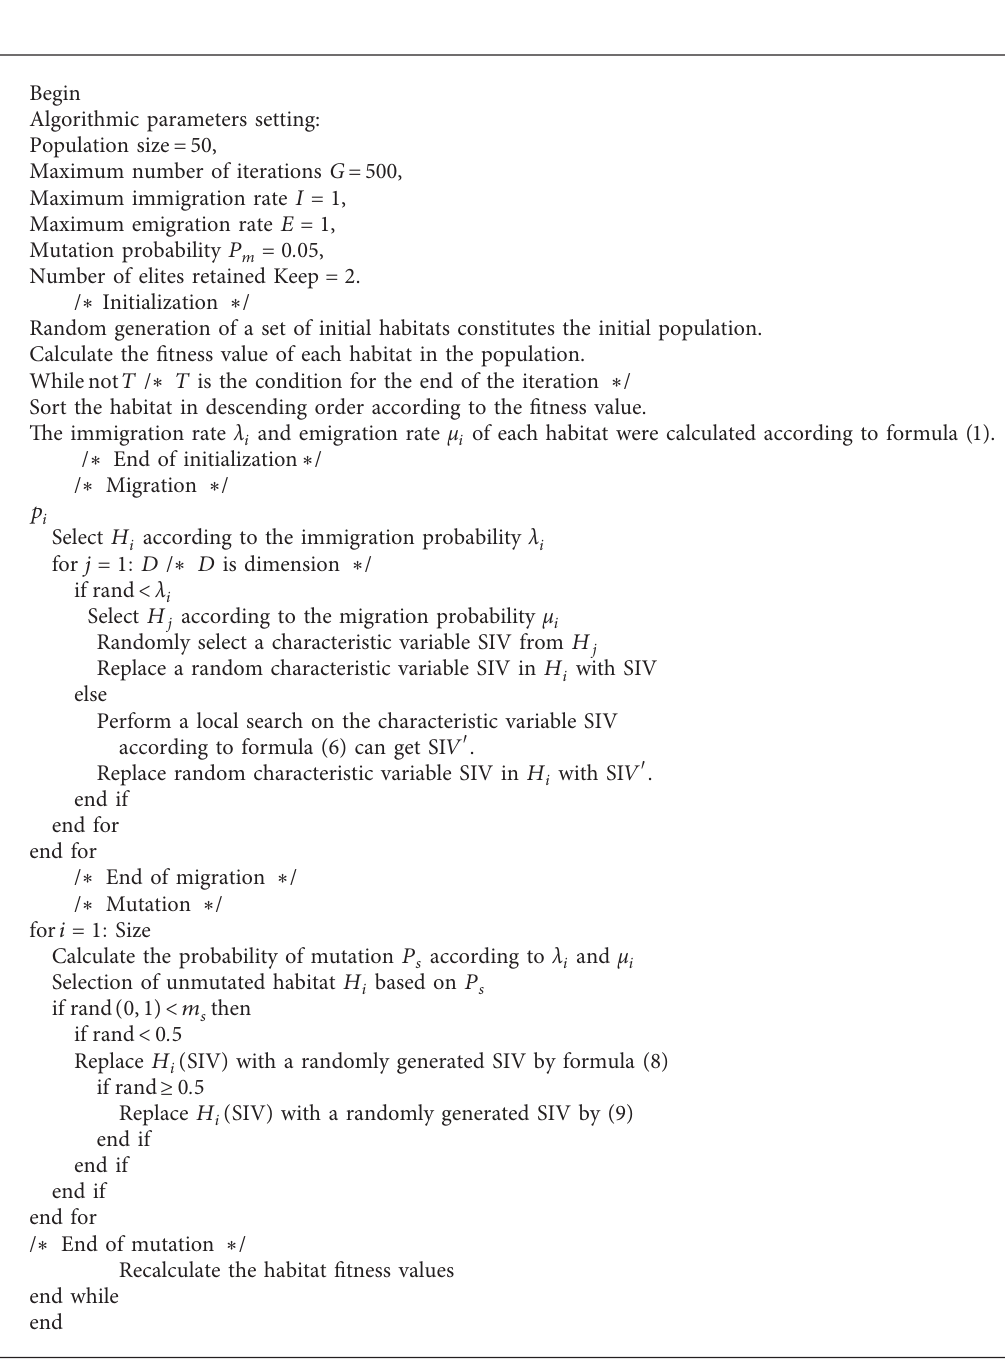
A LGORITHM 1: The main procedure of algorithm. In the iterative process of the algorithm, we record the best fitness of each evaluation, find the average optimal value of each evaluation and draw a curve, which reflects the convergence trend of the algorithm. The con- vergence curves of some test functions are shown in Fig- ures 2 and 3.